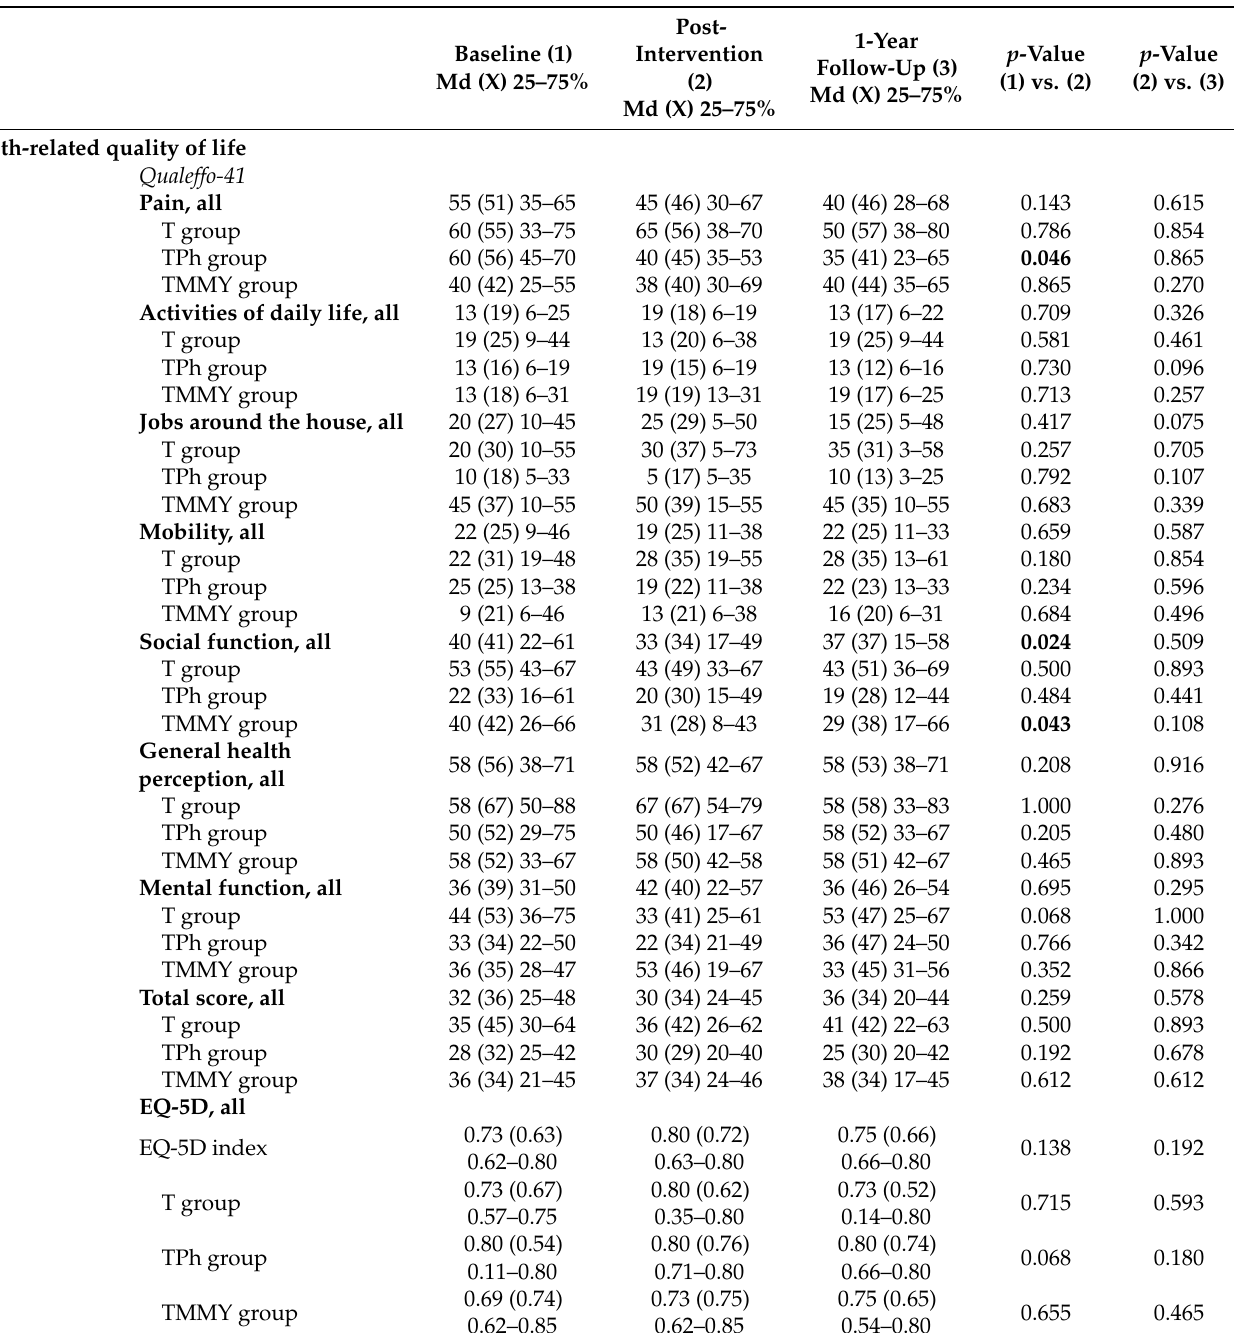
Table 3. Health-related quality of life and the change between the baseline, post-intervention, and 1-year post-intervention follow-up ( Qualeffo-41